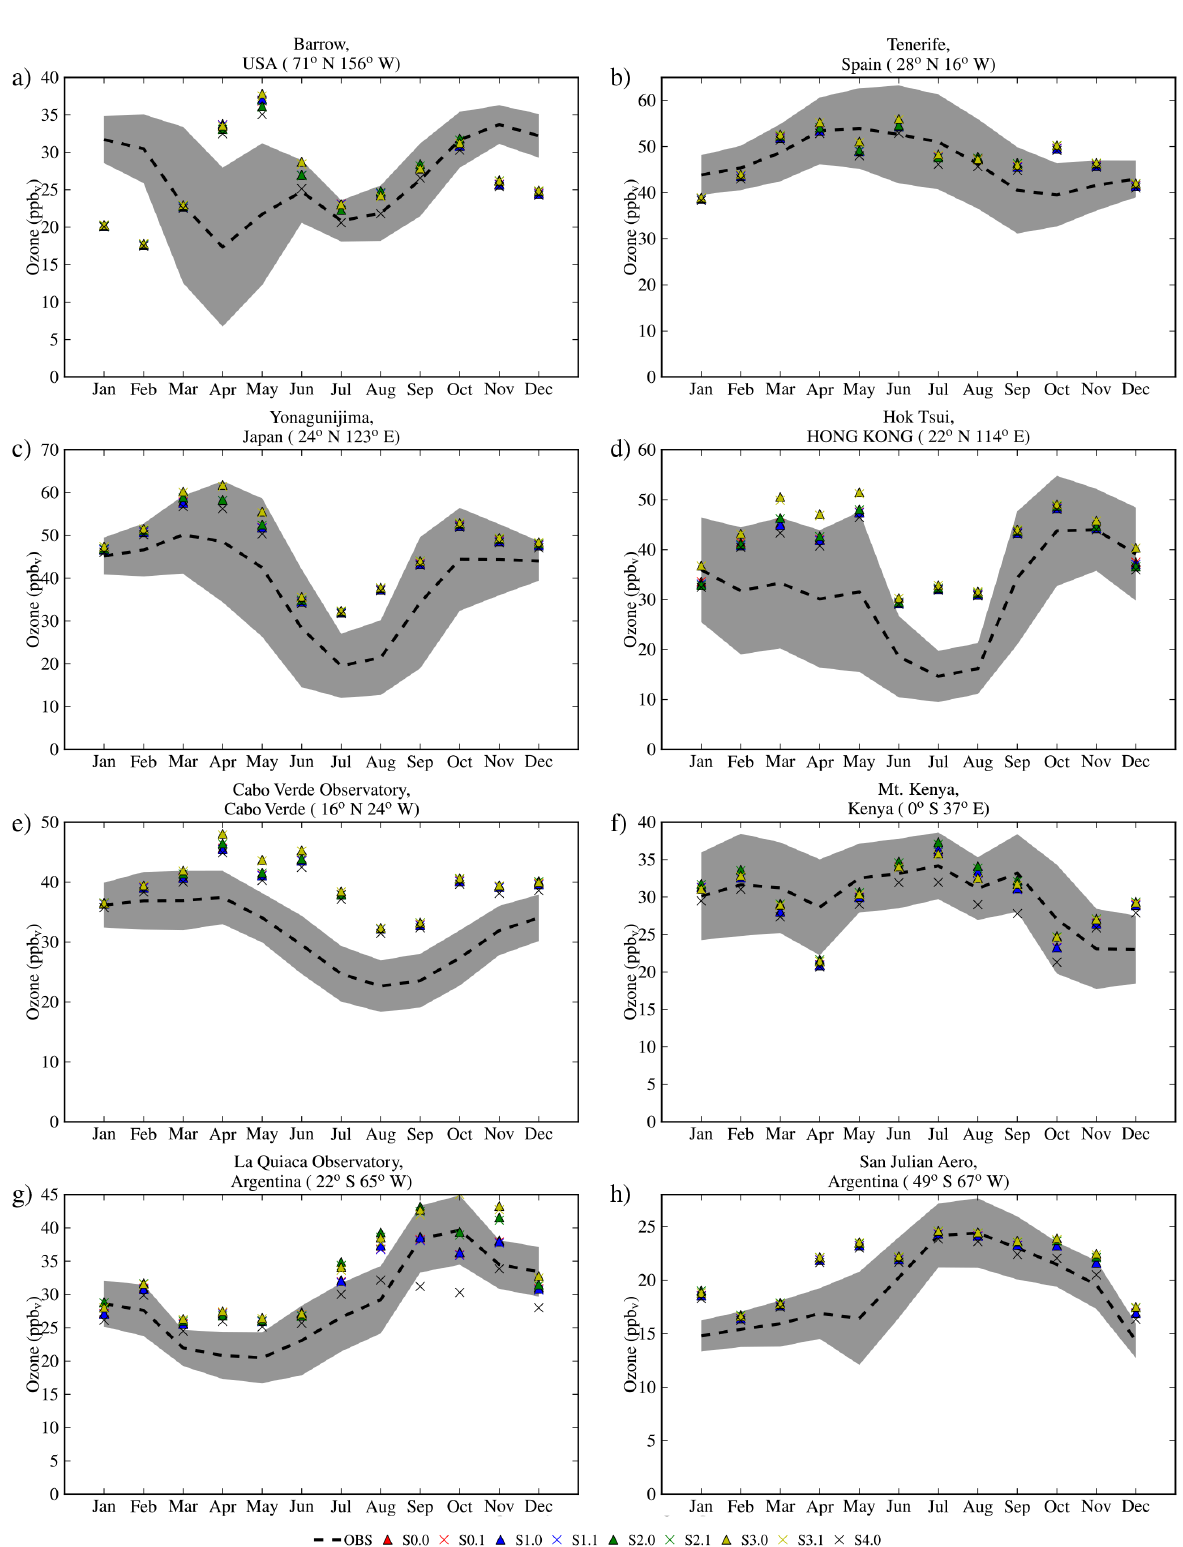
Figure 4. Comparison of monthly mean surface ozone measurements with model results at Barrow, USA (a) ; Tenerife, Spain (b) ; Yonagu- nijima, Japan (c) ; Hok Tsui, Hong Kong (d) ; Cabo Verde Observatory, Cabo Verde (e) ; Mount Kenya, Kenya (f) ; La Quiaca Observatory, Argentina (g) ; and San Julian Aero, Argentina (h) . Lines and symbols as in Fig. 2 but for O 3